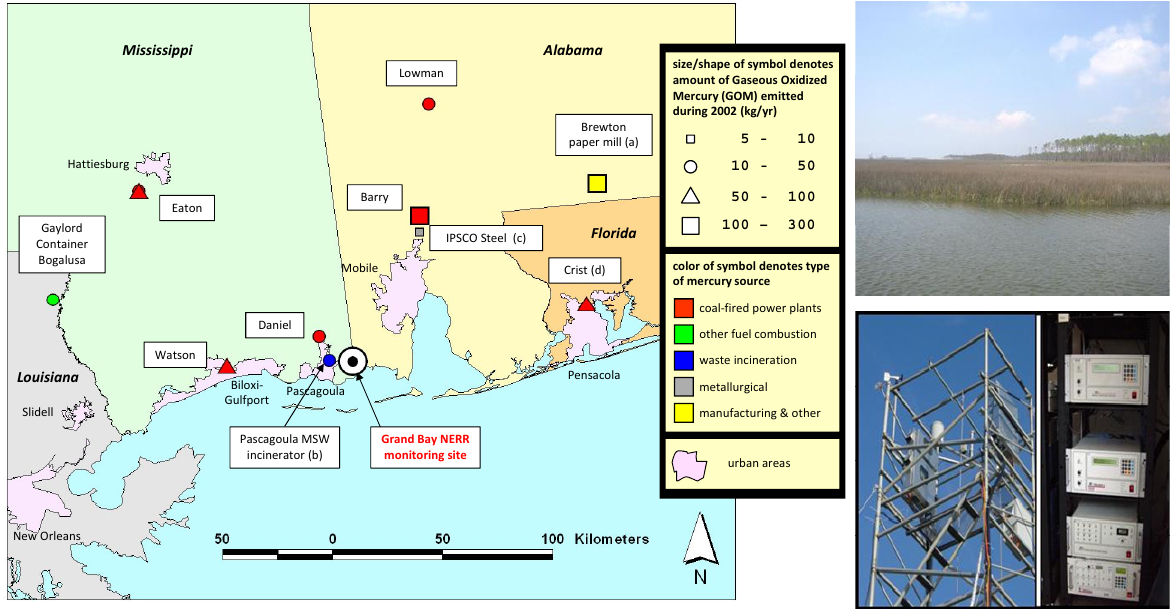
Figure 1. ( Left ) location of the Grand Bay NERR monitoring station, along with large point sources of gaseous oxidized mercury (GOM) in the region, based on the US EPA’s 2005 National Emissions Inventory (NEI). ( Right top ) site view from the Grand Bay NERR atmospheric mercury measurement tower. ( Right bottom ) the measurement tower at Grand Bay NERR, and two sets of Tekran mercury speciation units in a climate-controlled shelter adjacent to the